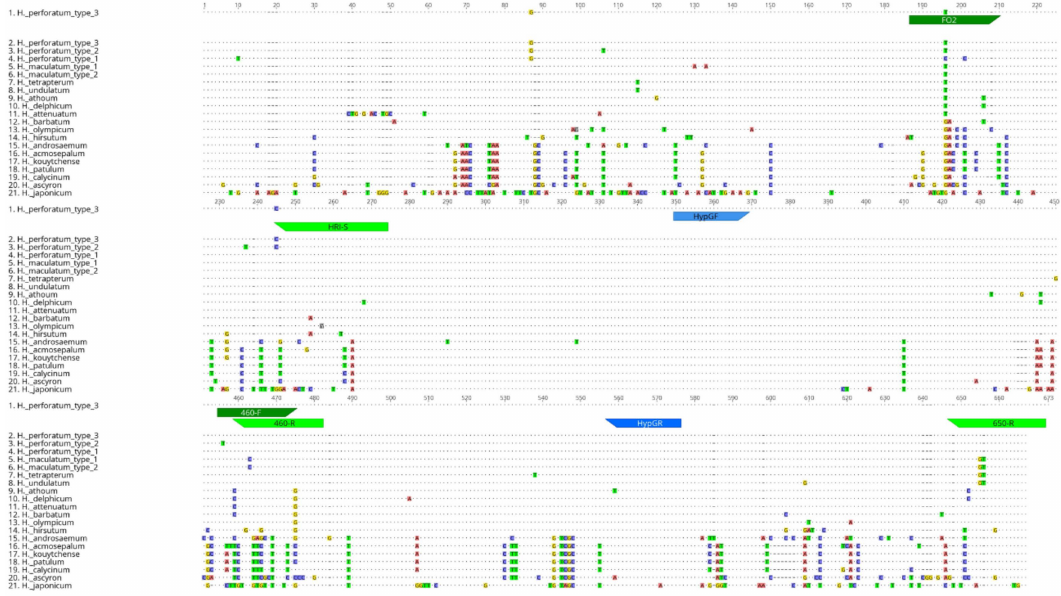
Figure 2. Multiple alignment of Hypericum ITS sequences showing the position of